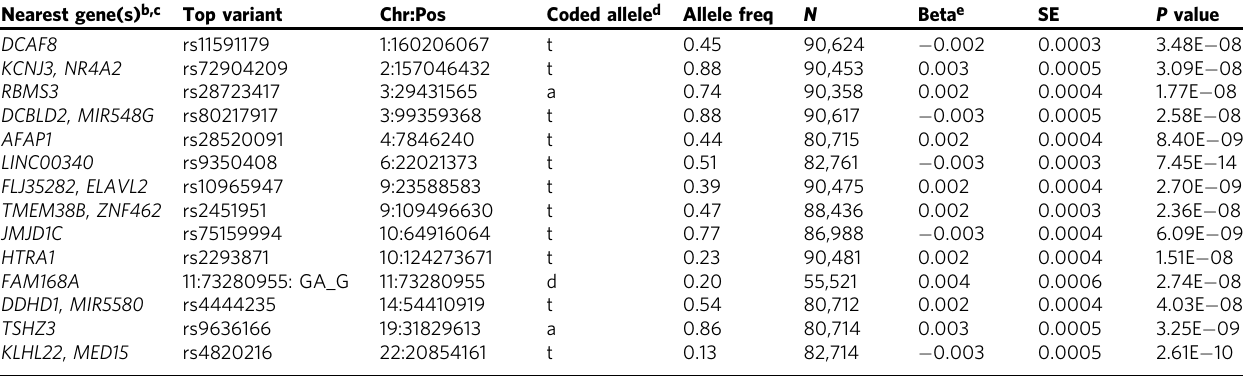
Table 6 Top variants from novel loci discovered in multiethnic meta-analysis of FEV 1 /FVC a in the CHARGE consortium Nearest gene(s) b,c Top